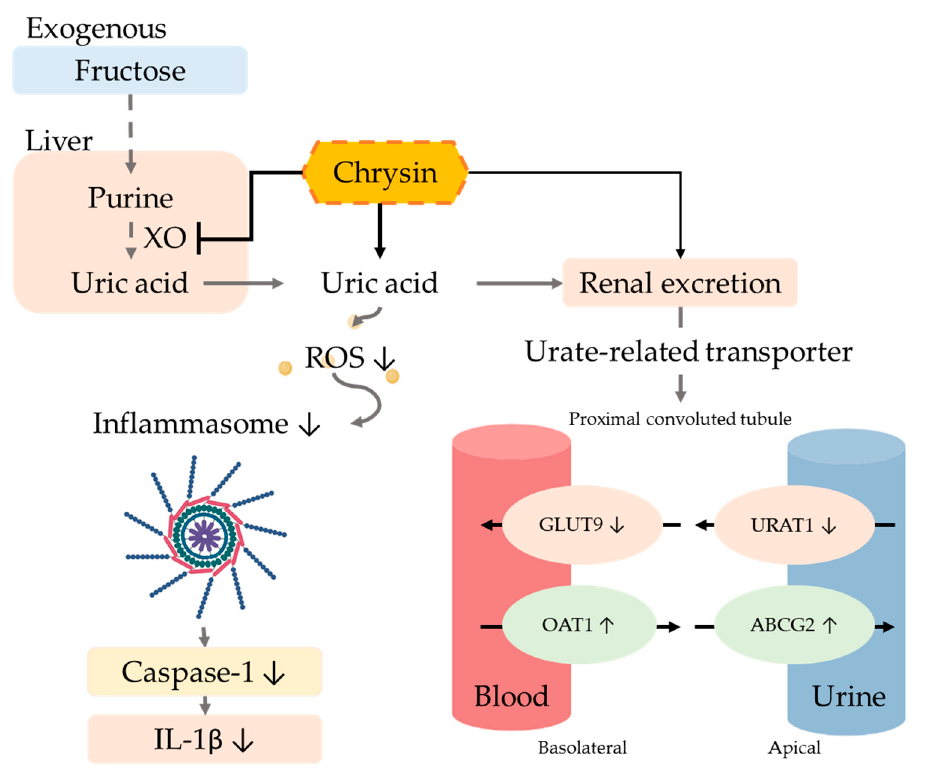
Figure 7. Potential mechanism of chrysin in hyperuricemic rats. The intervention of chrysin can effectively inhibit xanthine oxidase (XO) activity in the liver, thereby reducing the production of uric acid. Chrysin also reduces the reabsorption of uric acid by regulating uric acid-related transporters and promotes the excretion of uric acid in the urine, thus improving hyperuricemia. Finally, chrysin can reduce the IL-1 β concentration by the reduction of oxidative stress and the inactivation of inflammasome.